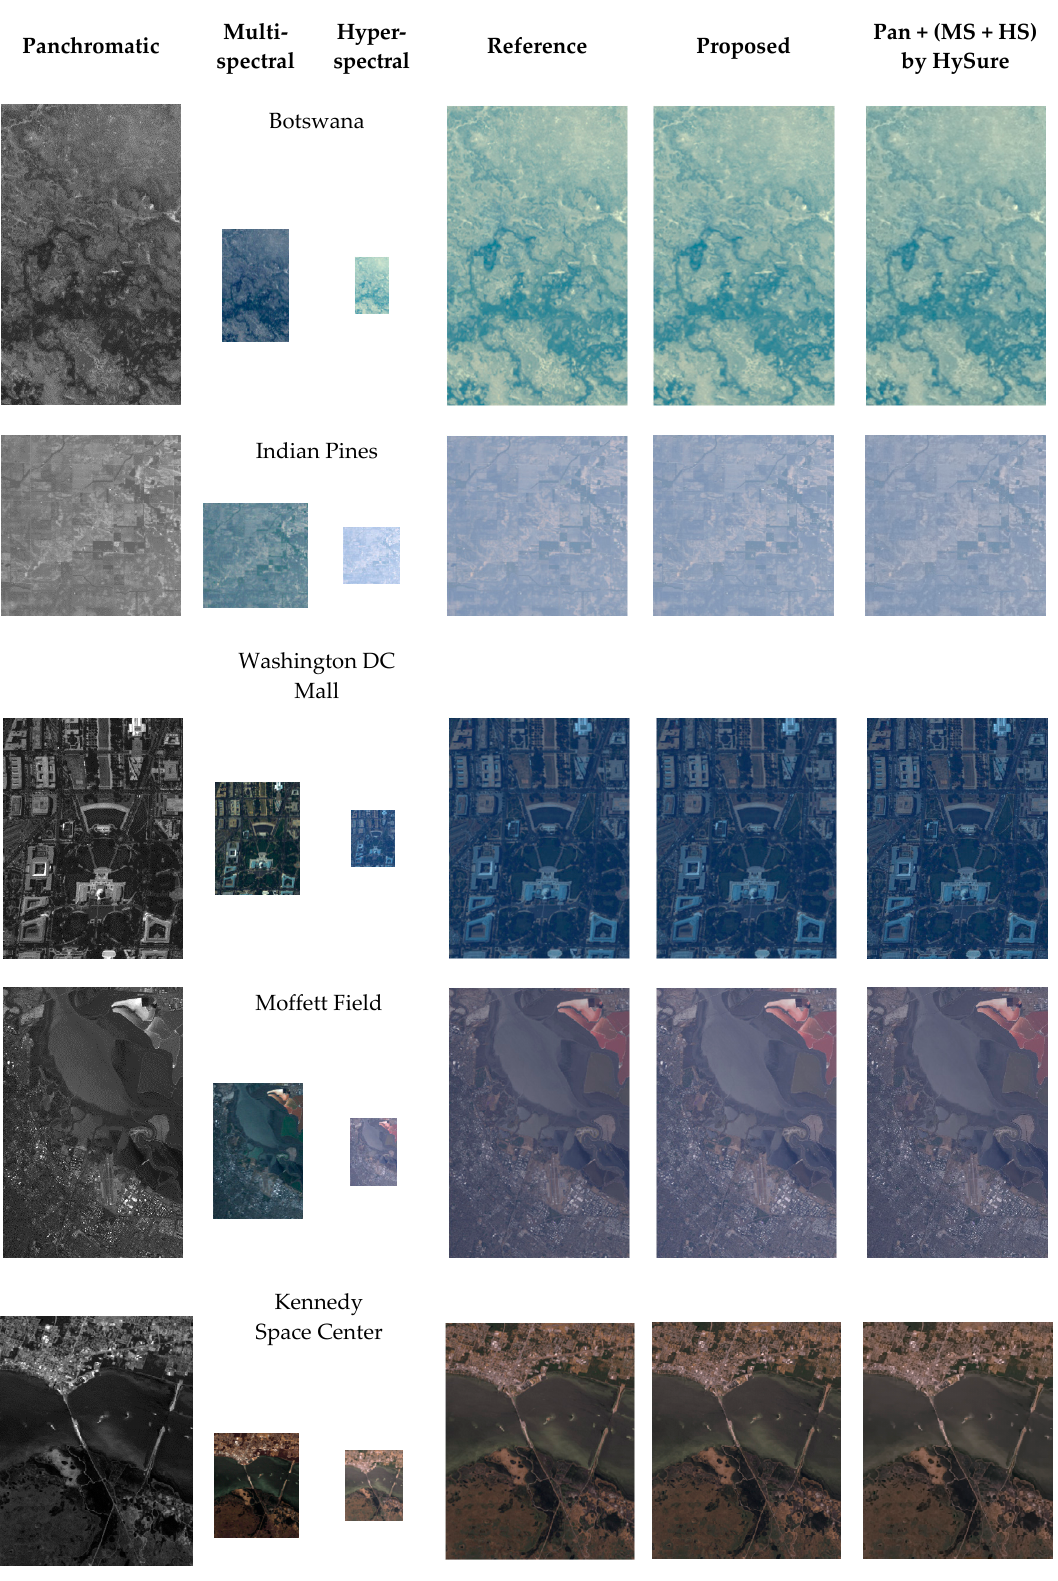
Figure 6. The panchromatic, multispectral, and hyperspectral images that are fused together, the reference hyperspectral image, and the fused images produced by the proposed algorithm and the Pan + (MS + HS) method using the HySure algorithm.